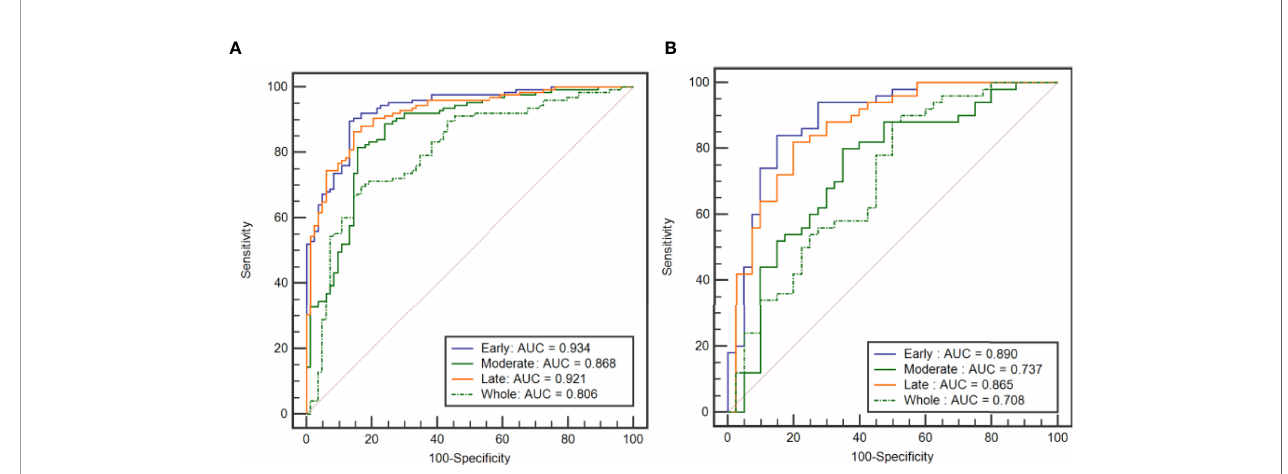
FIGURE 4 | ROC curves of the SVM classi fi cation models established by using the features extracted from the three intratumoral subregions and the whole tumor area. (A) ROC curves from the training cohort. (B) ROC curves from the external validation cohort.